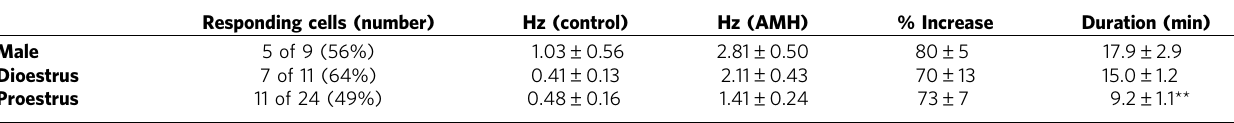
AMH, anti-Mu¨llerian hormone. Table showingthe numberof GnRH cells activated by AMH with% in brackets;the mean firing frequencybeforeand in responseto AMHexposure;the percentageincreaseinfiring rate,and durationof increased